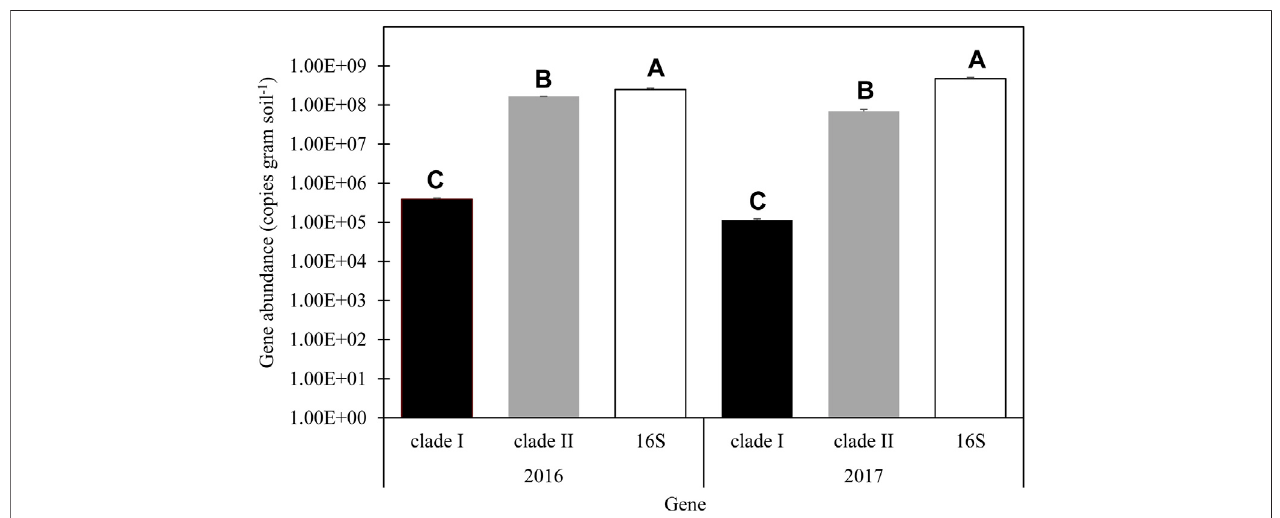
FIGURE 2 | Average abundance of nosZ clade I clade II and 16S in 2016 and 2017. Error bars represent standard error. LSM letters are different within year at p < 0.05.